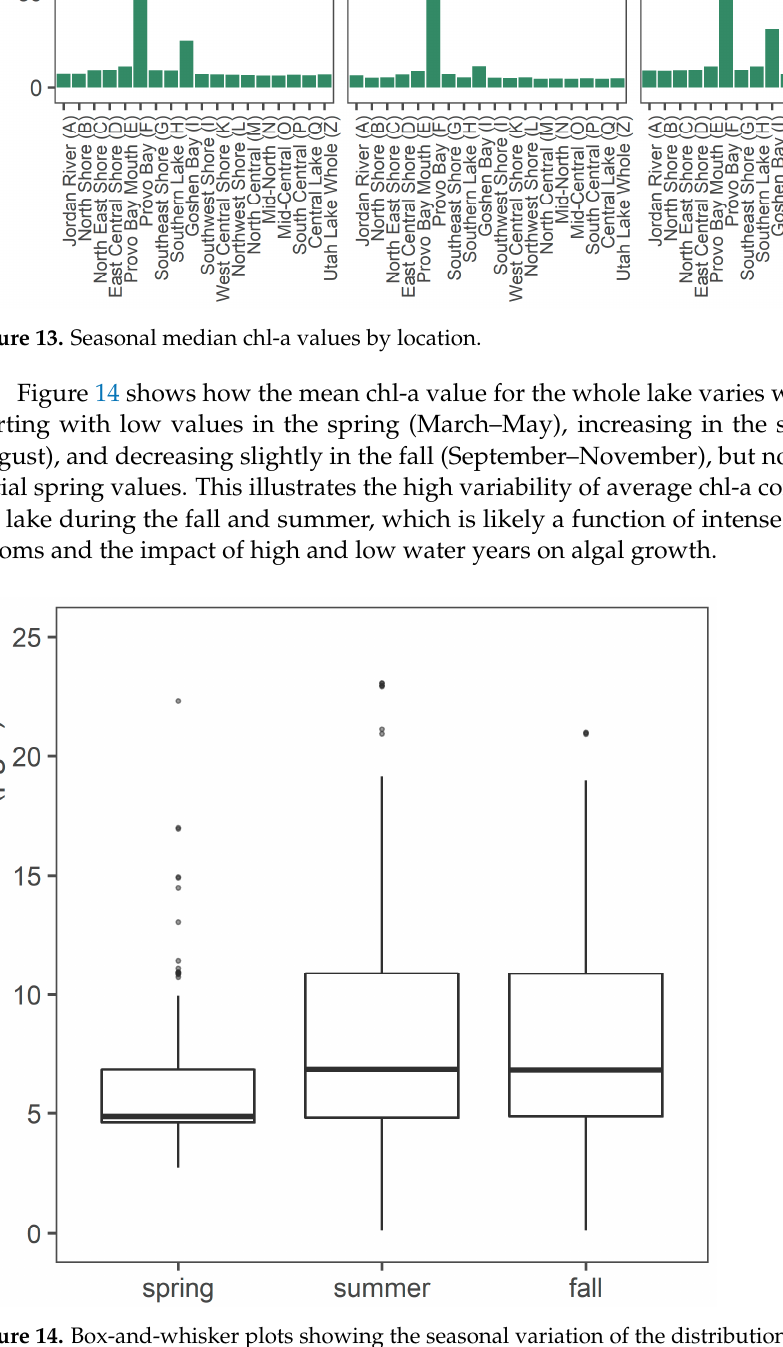
Figure 14. Box-and-whisker plots showing the seasonal variation of the distribution of median chl-a values for the entire lake over the 40-year study period. Outliers above 25 µg/L excluded.